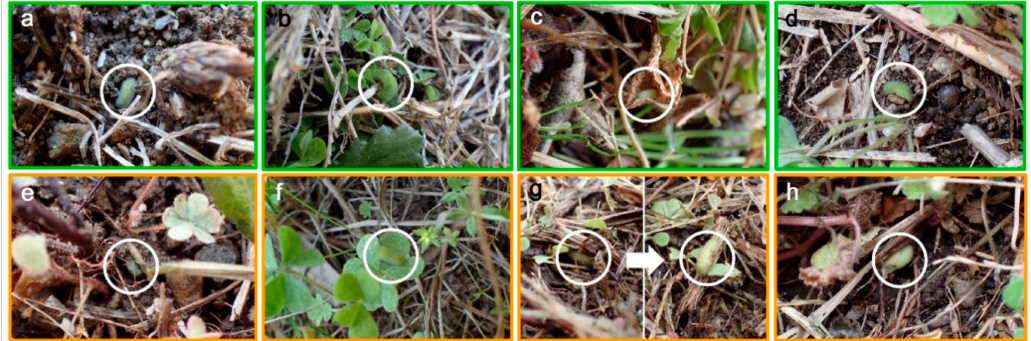
Figure 3. Larvae, prepupa, and pupa in the field (circled). Photographs taken in March are framed in green, and those taken in April are framed in yellow. ( a – f ) Larvae. ( a ) Fukushima in March 2018; ( b ) Iwaki in March 2018; ( c ) Rifu in March 2019, inside dried and curled Oxalis leaves; ( d ) Tokai in March 2019; ( e ) Fukushima in April 2019; ( f ) Kozaki in April 2019 on Oxalis leaves; ( g ) A prepupa in Fukushima in April 2019. The left panel shows the natural positioning, and the right panel shows a prepupa on dried straw after being removed; ( h ) A pupa in Iwaki in April 2019 on dried straw. We discovered larvae of various instars (first to fourth instars) as follows (Table 1). In March